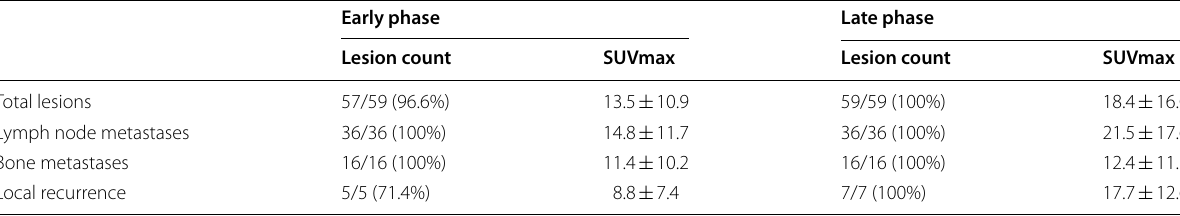
Table 2 Lesions detected in the scan-volume of late-phase (i.e. abdomino-pelvic only) Early phase